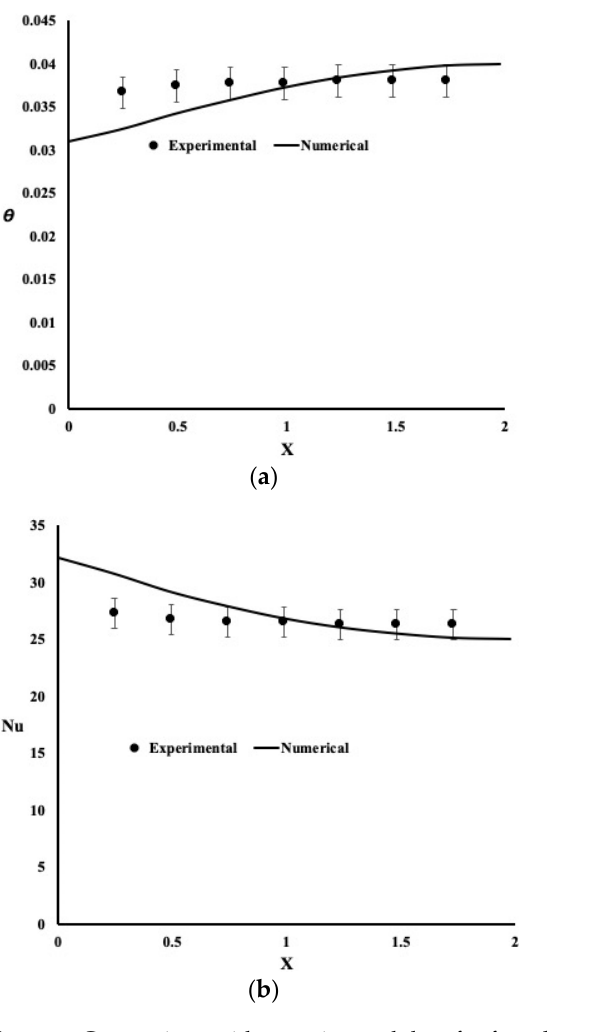
Figure 5. Comparison with experimental data for free channel case. ( a ) Temperature distribution, ( b ) Nusselt number variation.